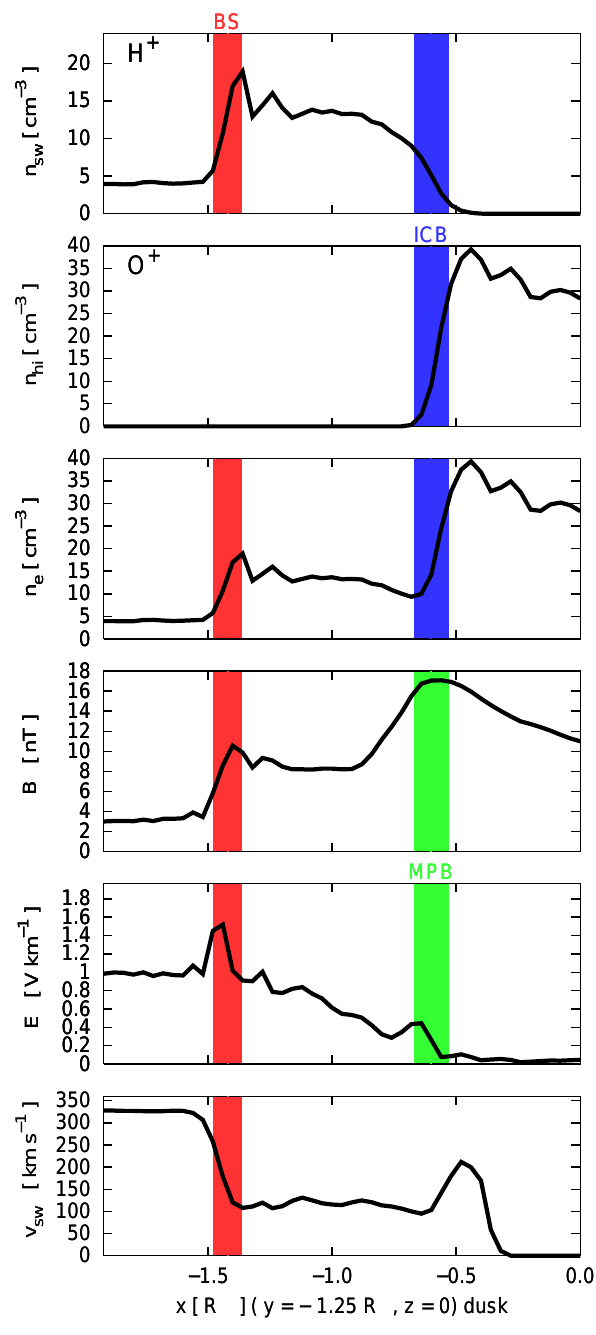
Fig. 11. Simulation results for the “standard run”. Plasma and field parameters along a line parallel to the x-axis in the equatorial plane at y =− 1 . 25 R M and z = 0 (straight white line in Fig. 10 l ). These results should be compared to the measurements made by Phobos-2 in Fig. 2. The figure shows the number density of the solar wind protons and the planetary O + ions, the electron density, the magnetic and the electric field absolute values and the velocity of the solar wind, respectively. The color bars indicate the location of the BS (red), ICB (blue) and MPB (green). The magnetic field and electron density are in good agreement with the observed data. The proton density measured by Phobos-2, however, shows a pronounced foot region, which is not present in our results, due to a differing field geometry described in the text. The interplanetary electric field decreases after the bow shock and vanishes inside of the ICB. However, a small peak just in front of the ICB can be seen. The proton velocity remains constant behind the bow shock but it is increased directly behind the ICB. The very low proton density at this point indicates that only the fastest thermal solar wind protons are able to cross the boundary, leading to this increasing of the bulk velocity. The MPB and ICB are located at the same position, which is in accordance to the Phobos-2 observations. Parameters: see Fig.